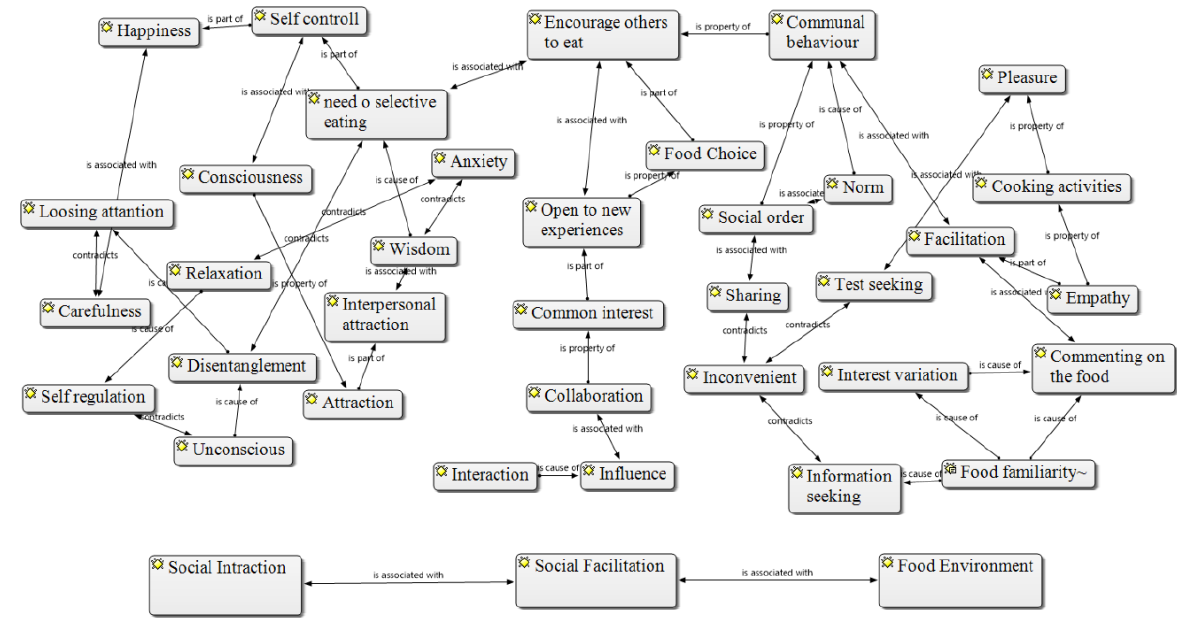
Figure 1 : Visualizing Network Diagram Semantic Relationship of Eating Together in